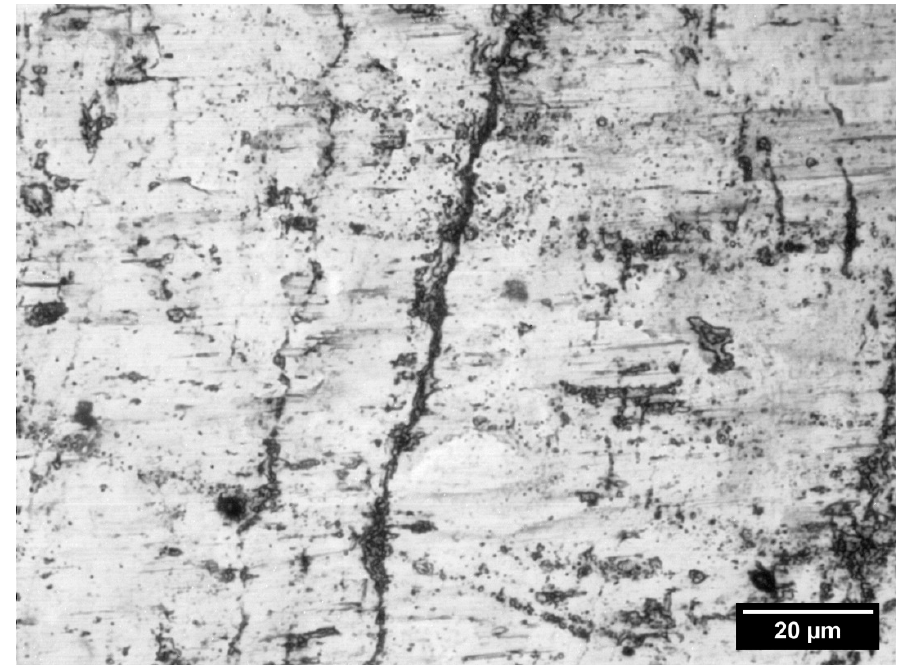
Figure 9. Cracks at the surface after 50% cold rolling.